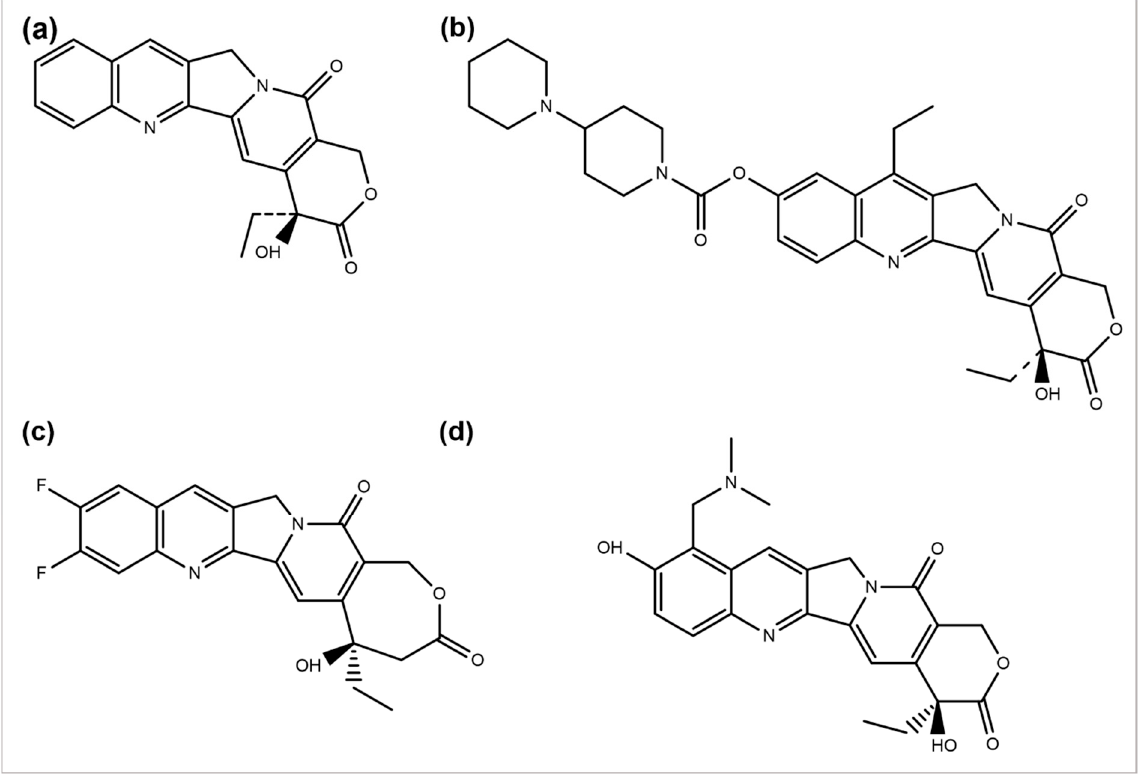
Figure 3. Chemical structures of ( a ) camptothecin, ( b ) irinotecan, ( c ) diflomotecan, and ( d ) topo-